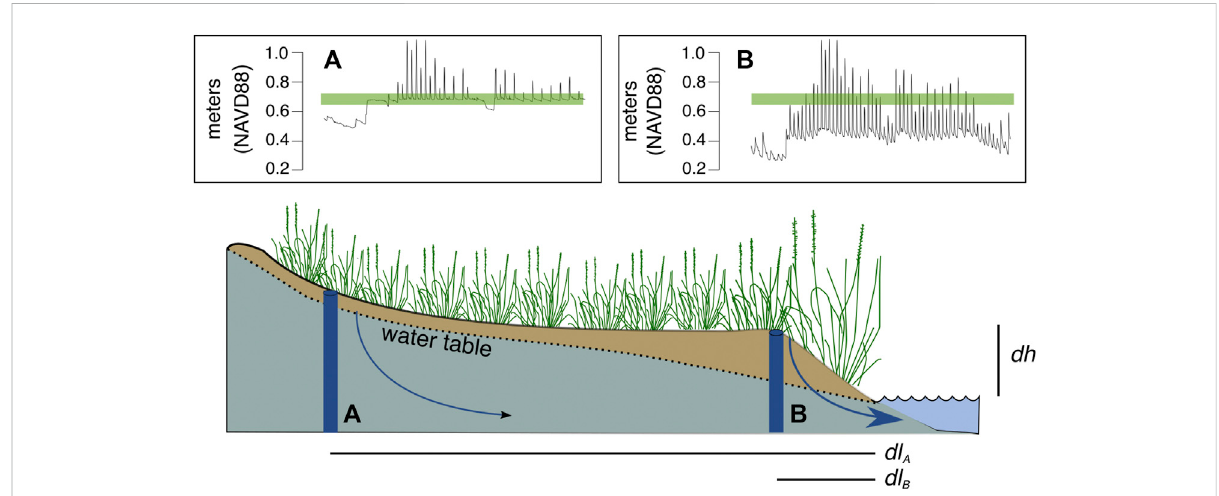
FIGURE 2 Incoastalmarshes,thewater tabletendstobeclosetothemarshsurface(indicatedbythegreenline)inthemarshinterior,i.e.,30 m+fromthe marsh edge, demarcated in this fi gure as location (A) . Along the edge of the marsh where it intercepts the tidal creek, the water table drops to much lower elevations at low tide, demarcated in this fi gure as location (B) . This is because through-marsh drainage is proportional to the product of soil hydraulic conductivity ( K ) and the hydraulic gradient ( dh / dl ). Values for the hydrologic gradient are highest adjacent to the tidal channel but decrease proportionally with distance ( l ) from the creek edge. This explains why drainage is reduced at location (A) in comparison with location (B) . Water table elevations were measured in spring of 2016 at Colt State Park, Bristol, Rhode Island (41.6769 ° N, 71.2985 °